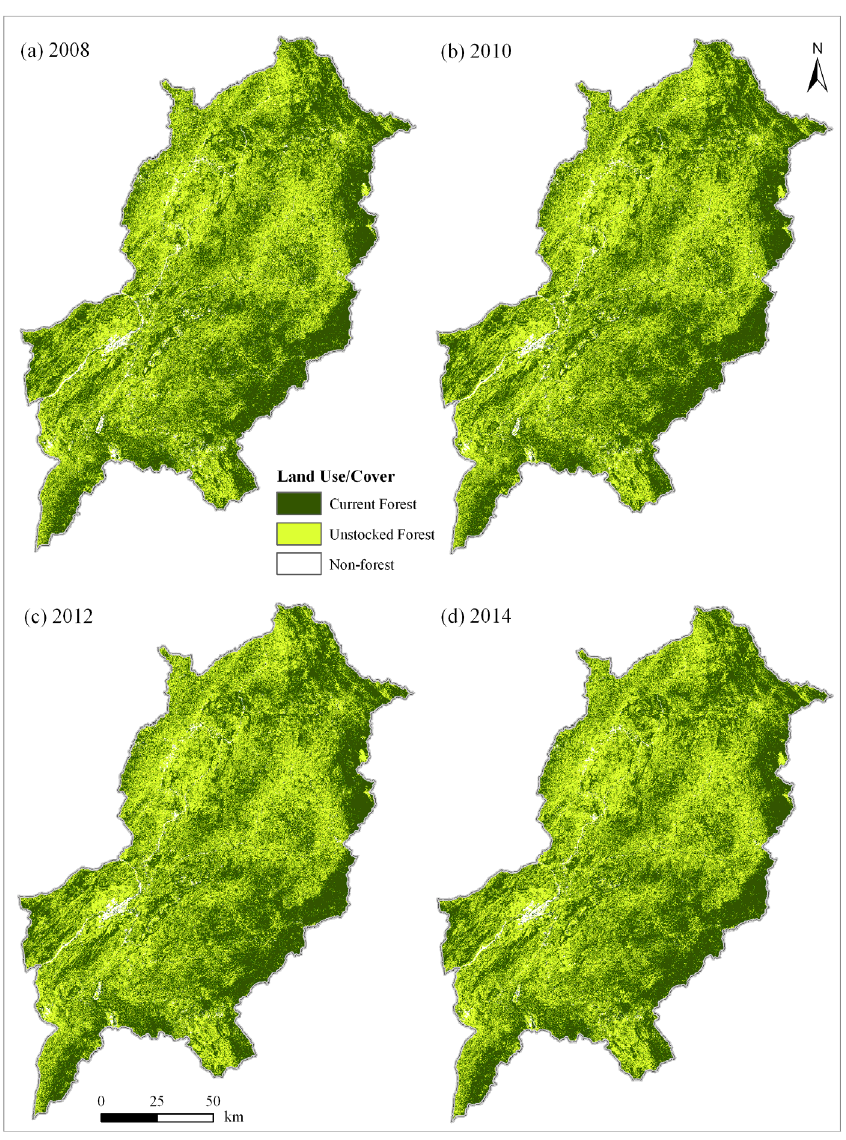
Figure 10. Simulations under the optimistic